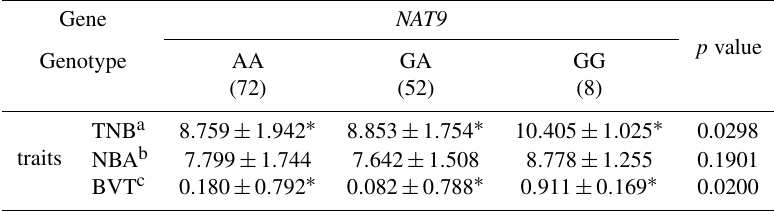
Table 4. Association of litter size traits with NAT9 genotypes in the secondary experiment.